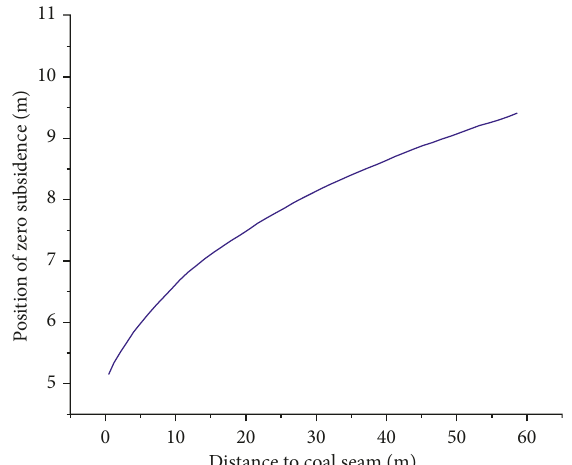
Figure 10: Influence of the level on the subsidence of the voussoir beam structure.